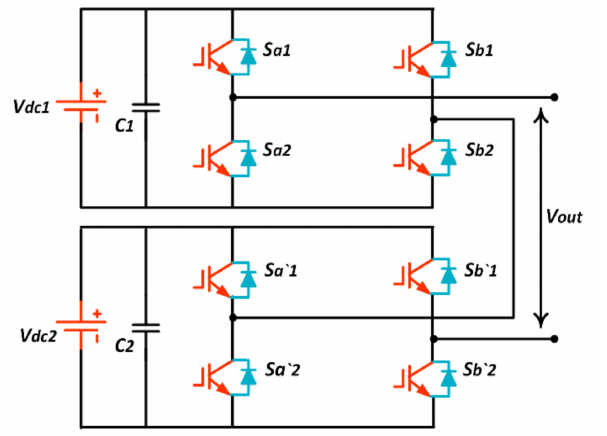
Figure 33. Cascaded multilevel inverters